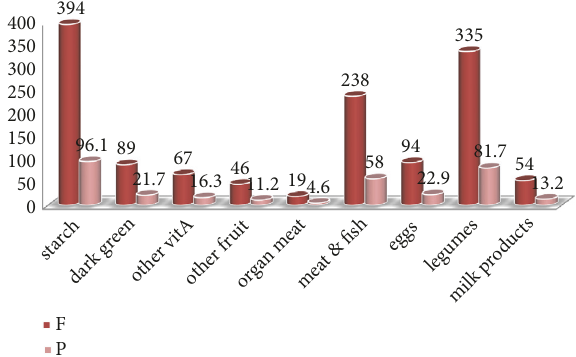
Figure 1: Twenty-four-hour food group consumption of adult HIV patients in Motta town public health facilities, April,